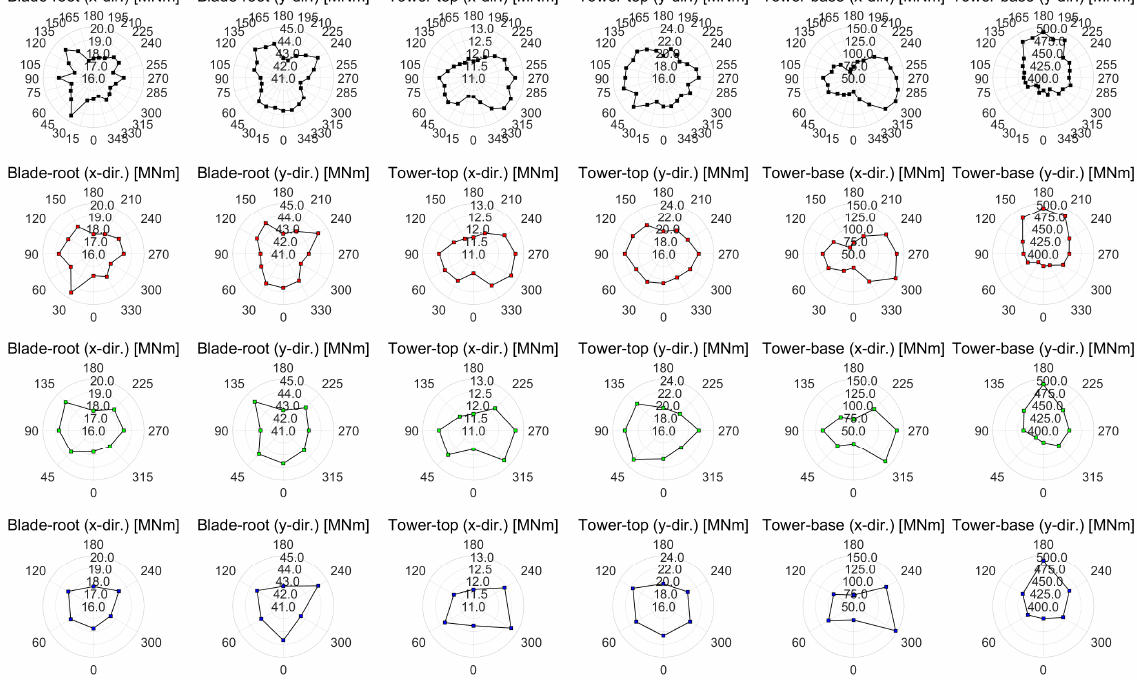
Figure 15. Maximum values of the blade and tower’s moments according to the interval angles.